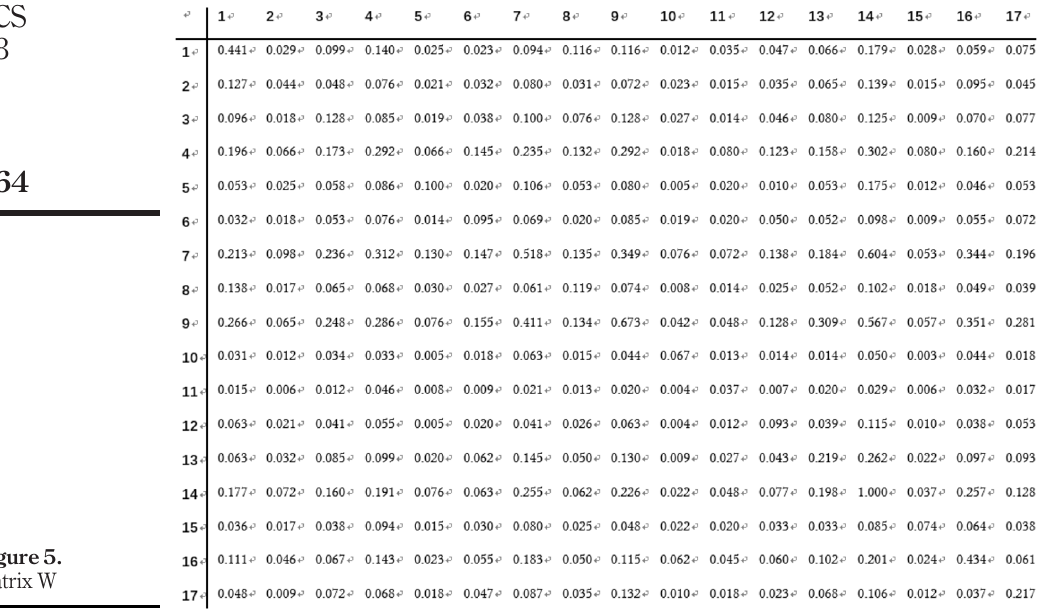
Figure 5. Matrix